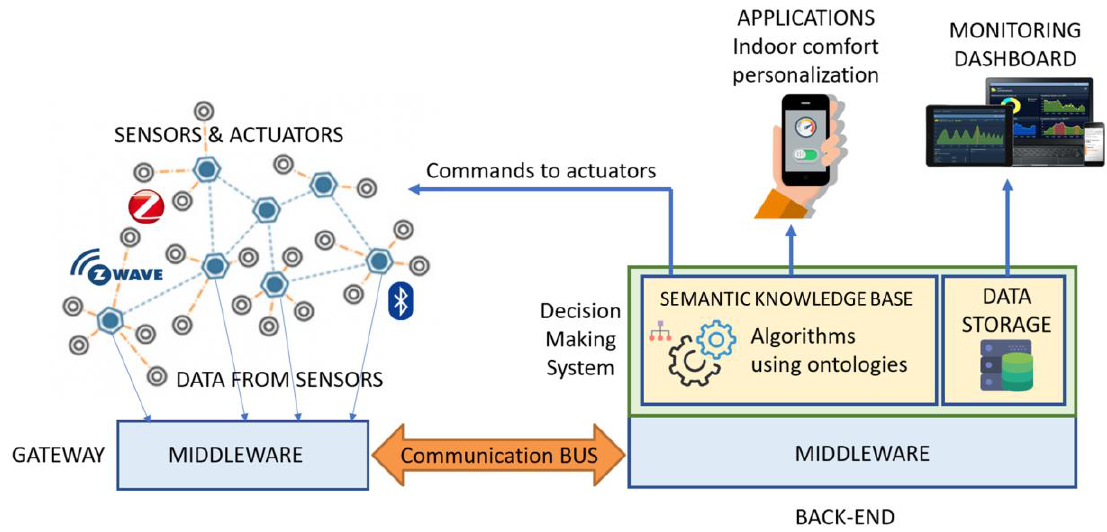
Figure 1. A schema representing the E-Cabin architecture.